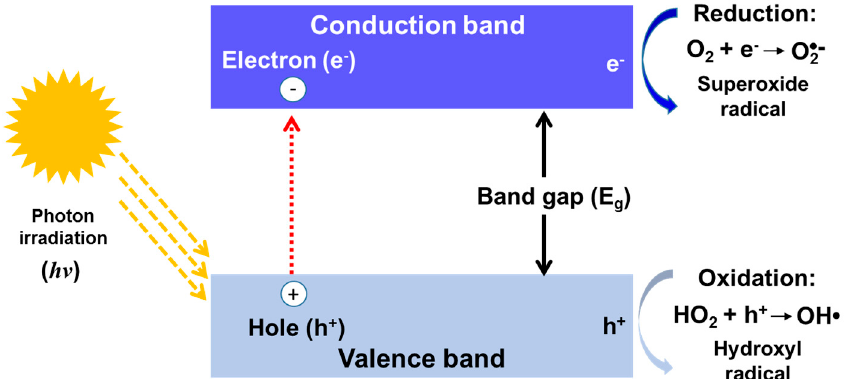
Figure 1. Schematic illustration of the photocatalytic reaction process of a semiconductor. Adapted with permission from Reference [18]. Copyright (2012)